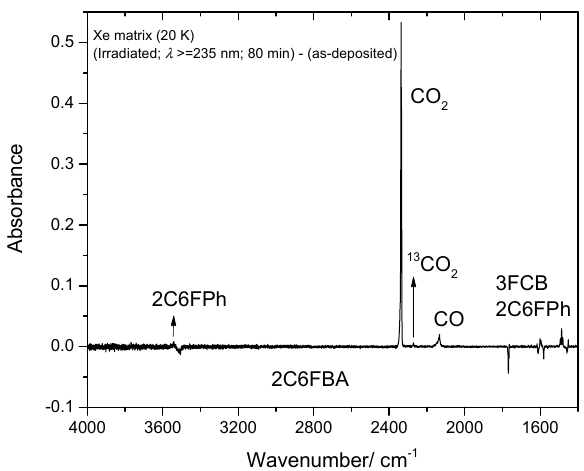
Figure 17. High frequency region of the difference IR spectrum: irradiated Xe matrix of 2-chloro-6-fluorobenzoic acid (2C6FBA) minus as-deposited matrix. Bands that arise due to the photoproduced CO 2 (including its 13 C isotopologue), CO, 2-chloro-6-fluorophenol (2C6FPh) and 3-fluoro-chlorobenzene (3FCB) are pointing up, while bands due to the reactant ( cis conformer) are pointing down. The lower frequency region shown in this figure (<2000 cm − 1 ) was included to allow a faster comparison of the intensities of the bands with those presented in Figure 16.